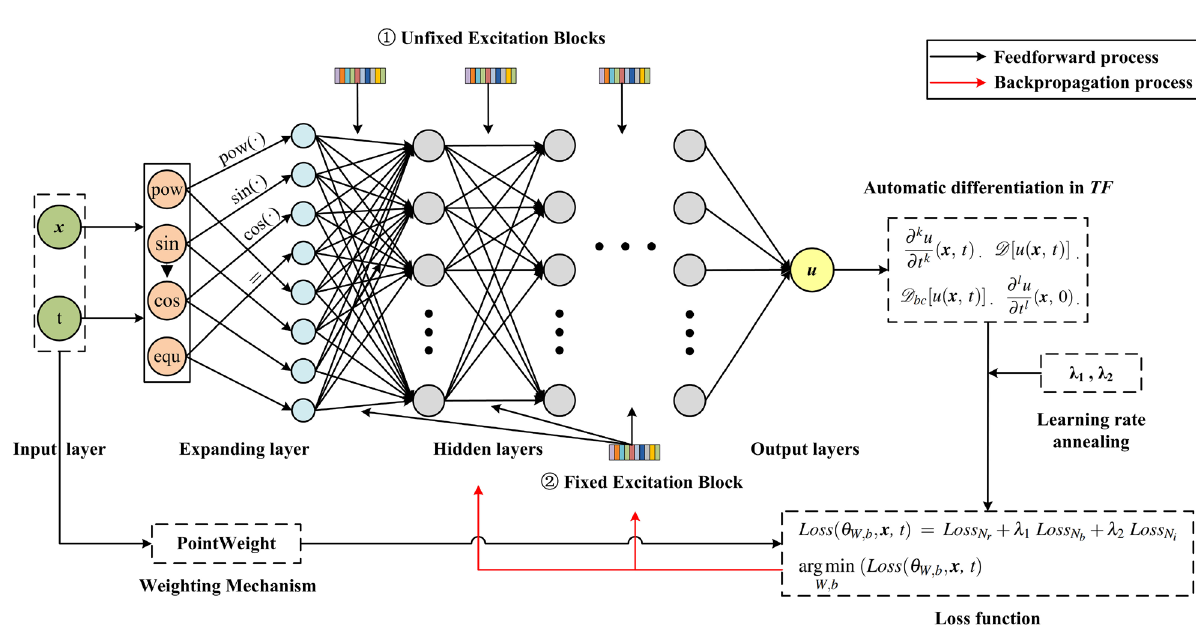
Figure 2. The overall pipeline of the proposed